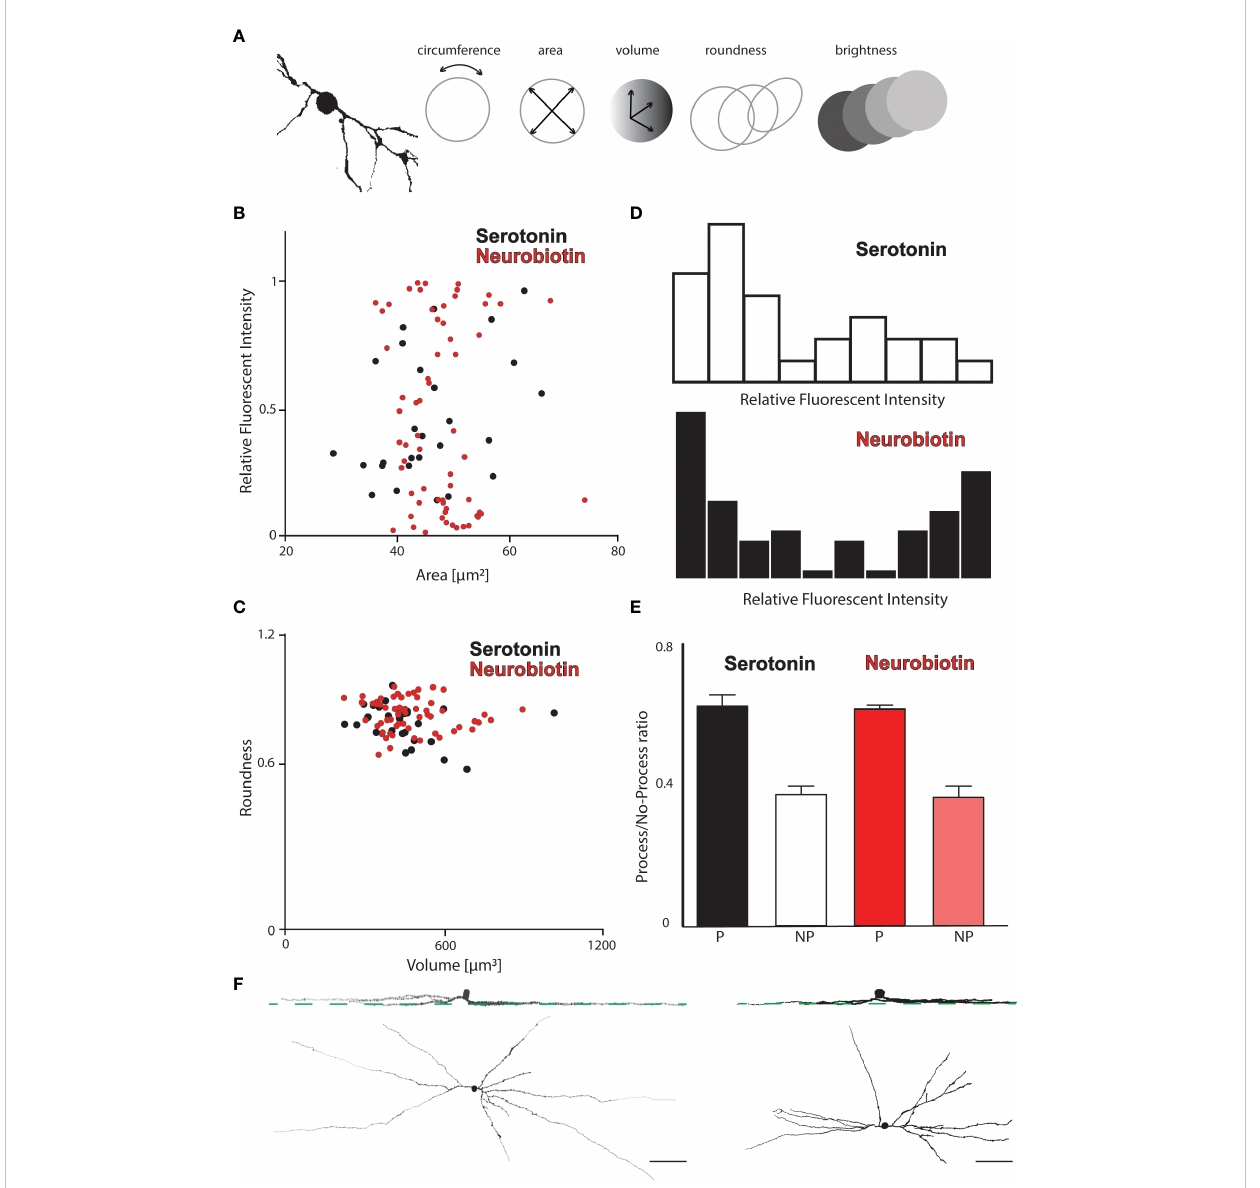
FIGURE 4 Morphometric analysis of tracer coupled ACs in the OFF alpha RGC array. (A) Schematic drawings show that the soma and primary dendrites of a reconstructed AC appeared coupled to an OFF alpha RGC (left) and display the measured morphologic features (circumference, area, volume, roundness, and brightness) of coupled AC somata. (B) Histogram displaying the fl uorescent intensities of tracer-coupled ACs in the serotonin-injected (black) and NB-injected (red) OFF alpha RGC arrays as a function of the soma area (pooled data from four serotonin and fi ve NB OFF alpha cell injections). While both tracers labeled ACs with various soma sizes equally, the fl uorescence intensity appears to distinguish between a bright and a dim AC population in both injections. (C) Histogram displaying the roundness of tracer-coupled ACs in the serotonin-injected (black) and NB-injected (red) OFF alpha RGC arrays as a function of the soma volume. Neither serotonin- nor NB-coupled AC somata could be further divided based on these two characteristics. (D) Histograms show the frequency of AC somata with various relative fl uorescence intensities (relative to the brightness of the injected OFF alpha RGC) in serotonin-injected (top) and NB-injected (bottom) arrays. AC somata in both injected arrays seem to be separated into dimmer (left side) and brighter (right side) somata; however, this distinction between the two populations was more obvious in the NB-injected arrays, while serotonin-stained coupled ACs more homogeneously. (E) The result of an analysis in which AC somata were sorted into two subpopulations depending on the presence (P) or absence (NP) of visible processes. Values of P and NP AC somata are normalized to the total number of coupled ACs in a certain array (P + NP) to compare values across injections. Based on the data, serotonin and NB showed no difference in the staining of coupled ACs. In both injections, ≈ 60% of the coupled ACs displayed some dendritic processes, while for the rest ( ≈ 40%), only the somata were visible. (F) Panels showing face and side views of ACs that appeared to be tracer coupled to either NB- (left) or serotonin-injected (right) OFF alpha RGCs. Green dashed lines mark the strati fi cation level of HCN4-positive type 3a bipolar cell axon terminals in the IPL. Scale bar: 50